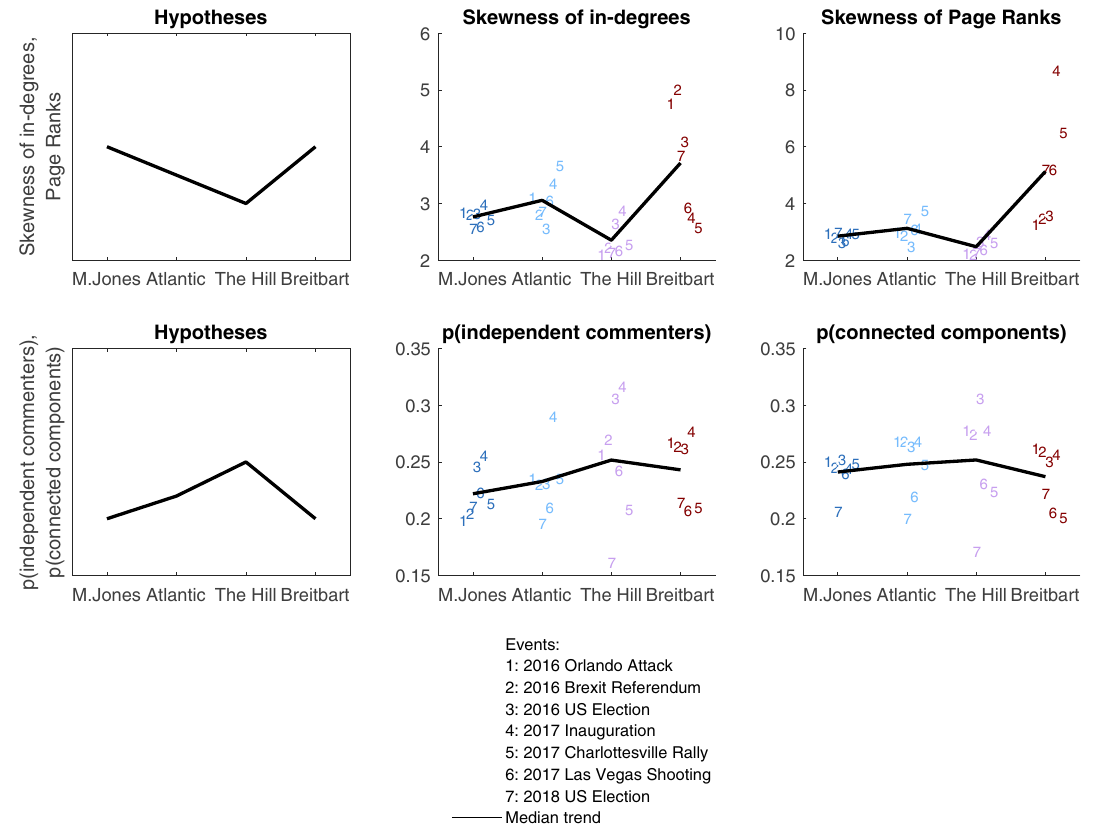
Figure 2. Differences in the overall inequality of attention, across different news websites and events, measured as the skew of centrality indices (first row) and properties of the overall network structure (second row) for the top 1% of commenters. The first column shows hypothesized median patterns of results. Numbers correspond to different events (see legend), and the line to the median trend across all events. Colors denote the political orientation of different sites as in Fig.